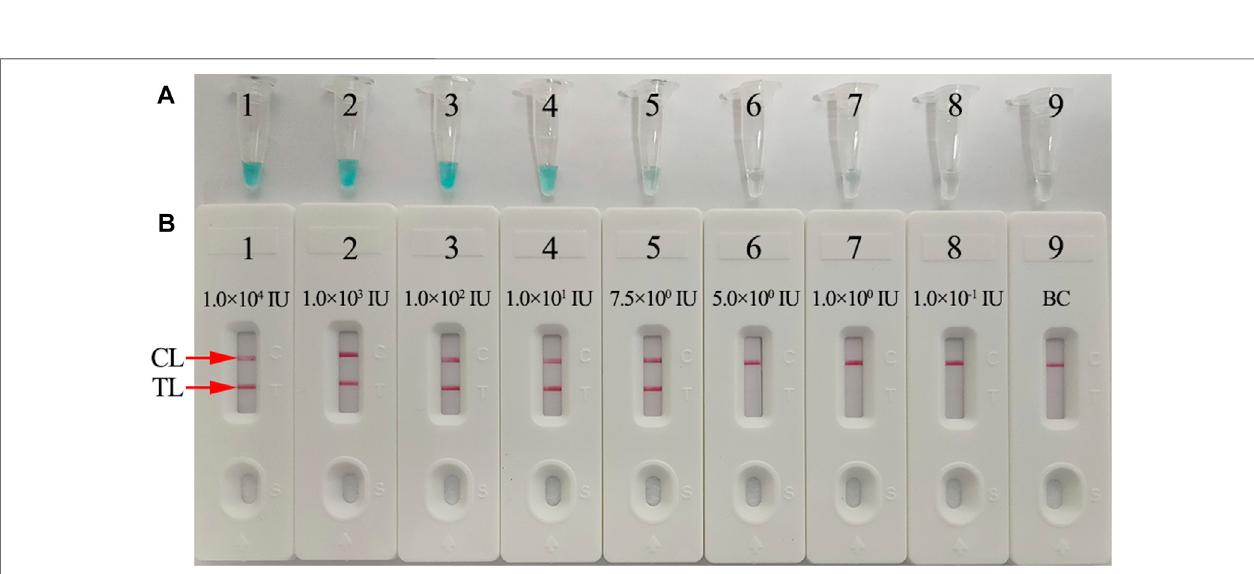
FIGURE 6 | Sensitivity analysis of the HBV-LAMP-LFB assay with serial dilutions of HBV genomic DNA concentrations. Two detection techniques, including colorimetric indicator (MG) (A) and LFB (B) , were used to analyze HBV-LAMP products. Tubes A1 – A9 (Biosensors B1 – B9) represent the genomic DNA amounts of 1 × 10 4 IU, 1 × 10 3 IU, 1 × 10 2 IU, 10 IU, 7.5 IU, 5 IU, 1 IU, and 0.1 IU per reaction and BC (DW), respectively. The LoD of the HBV-LAMP-LFB assay for S gene detection was 7.5 IU of the genomic template per reaction.